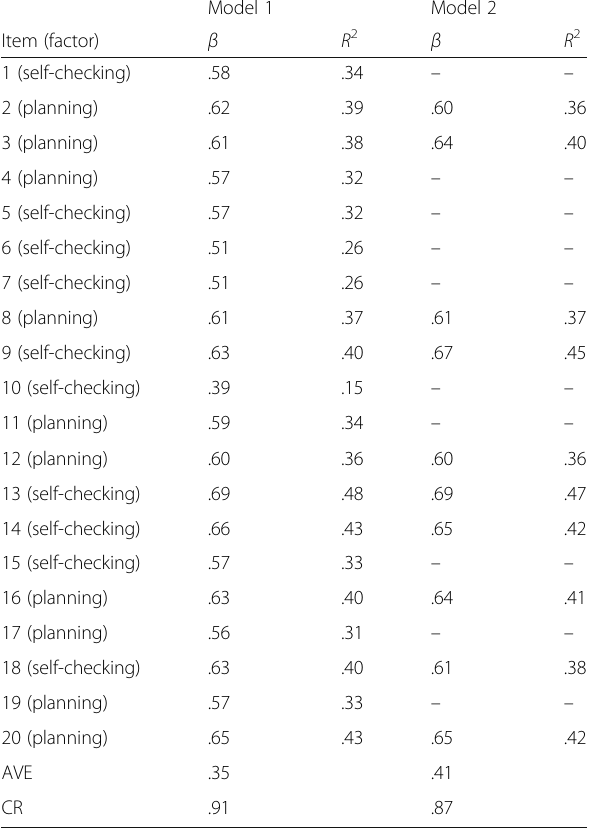
Table 1 IEM unifactorial model in the 2014/2015 sample: completely standardized maximum likelihood estimates, average variance extracted, and composite reliability Model 1 Model 2